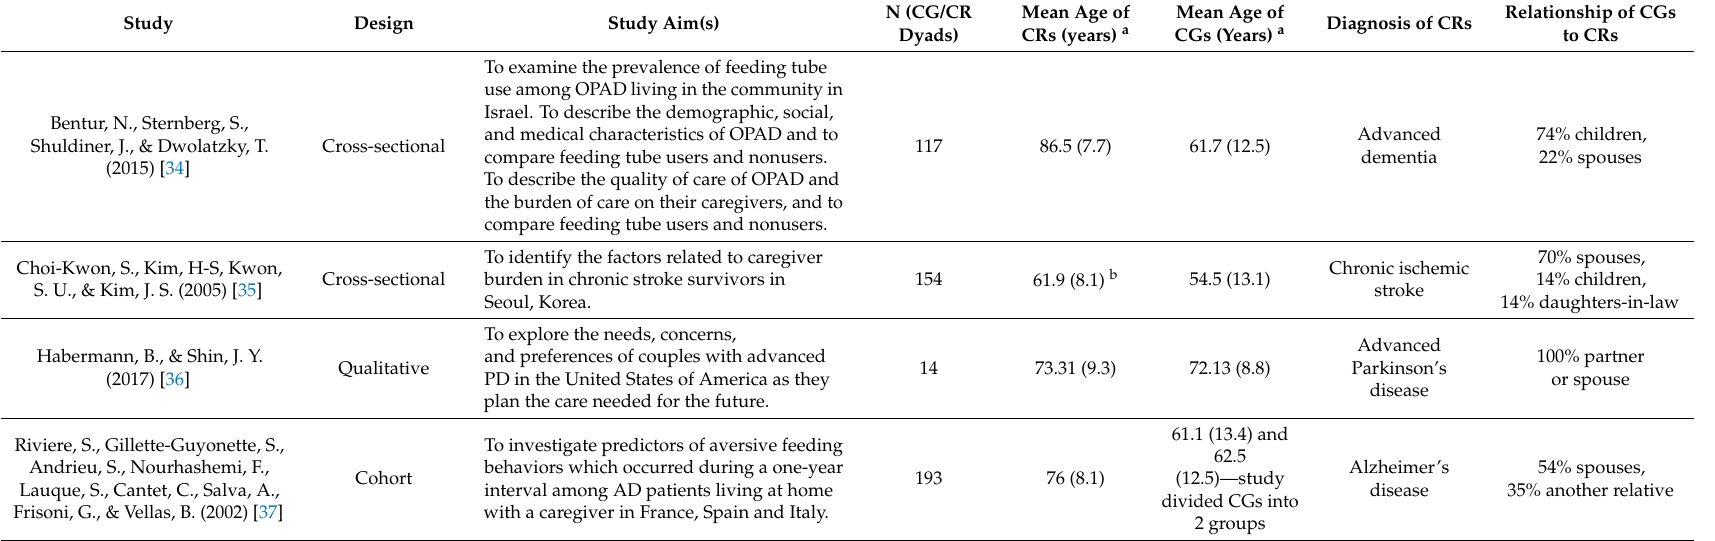
Table 1. Characteristics of all studies meeting criteria for inclusion in current systematic